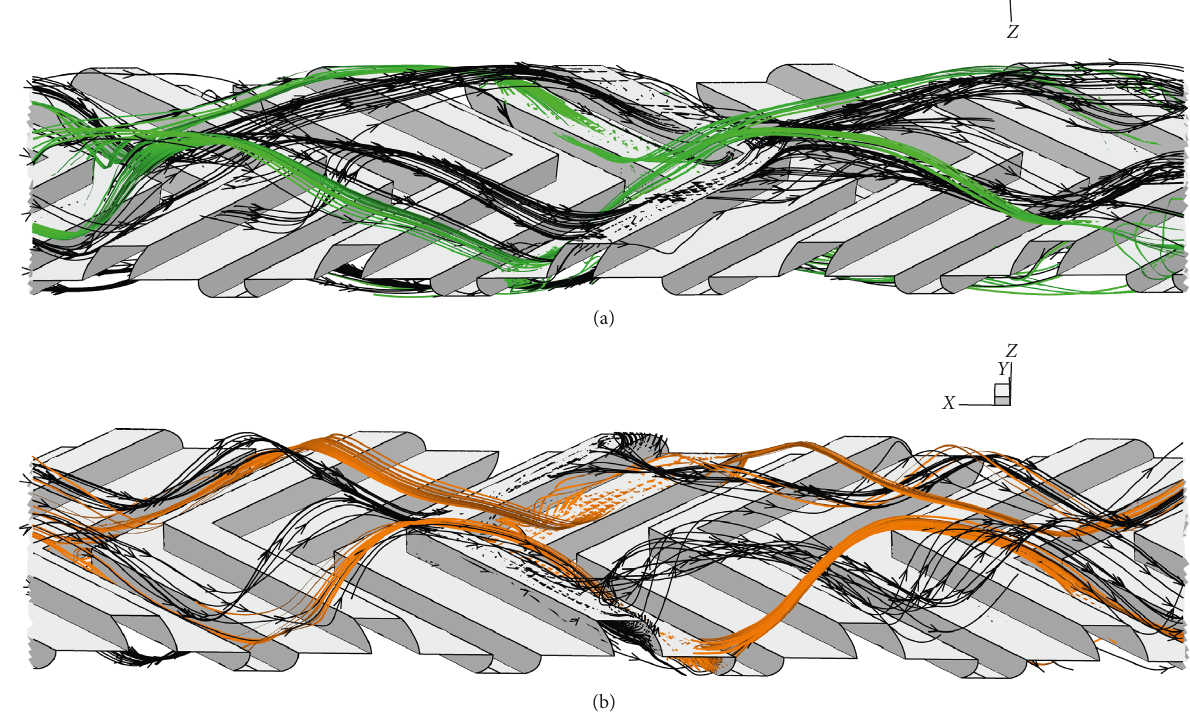
Figure 17: Longitudinal vortex flow of the heat exchanger tube inserted with the V-wavy surface at α Downstream and (b)